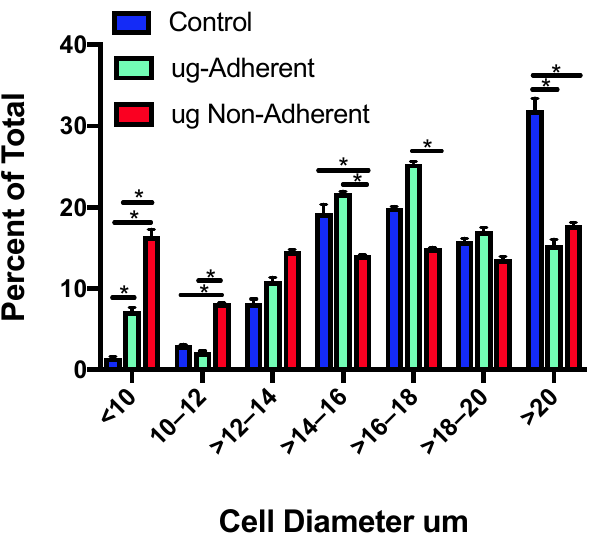
Figure 1. Binned cell diameters of control and simulated microgravity treated cells. The cell diame- ters of two populations of simulated microgravity cells (adherent and non-adherent) were de fi ned, binned based on size and compared with controls (average % diameter +/ − SE), * p < 0.004.